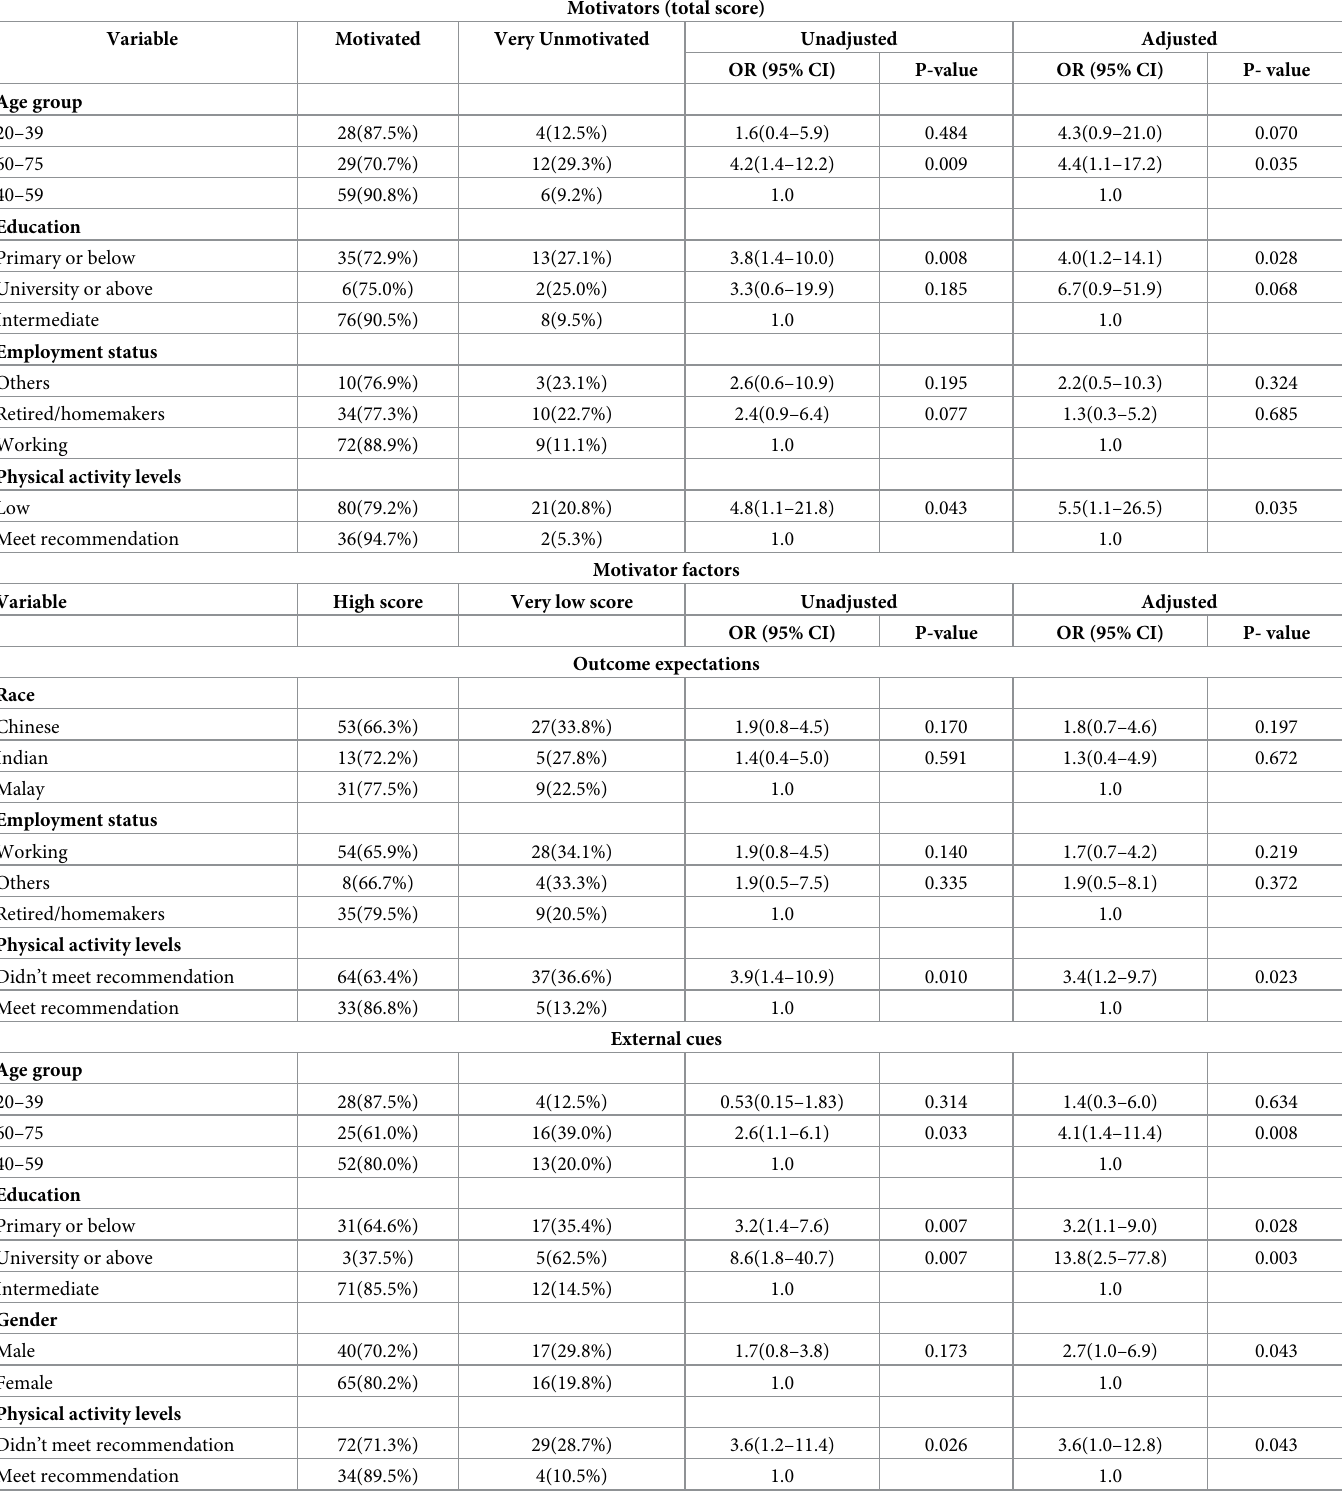
Table 5. Motivators and barriers among the obese: Overall score and